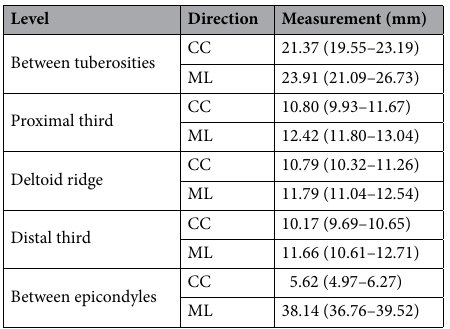
the deltoid ridge. The craniolateral to caudomedial internal diameter of the deltoid ridge measurement level was on average 16.41 mm (95% CI 15.47–17.35 mm).